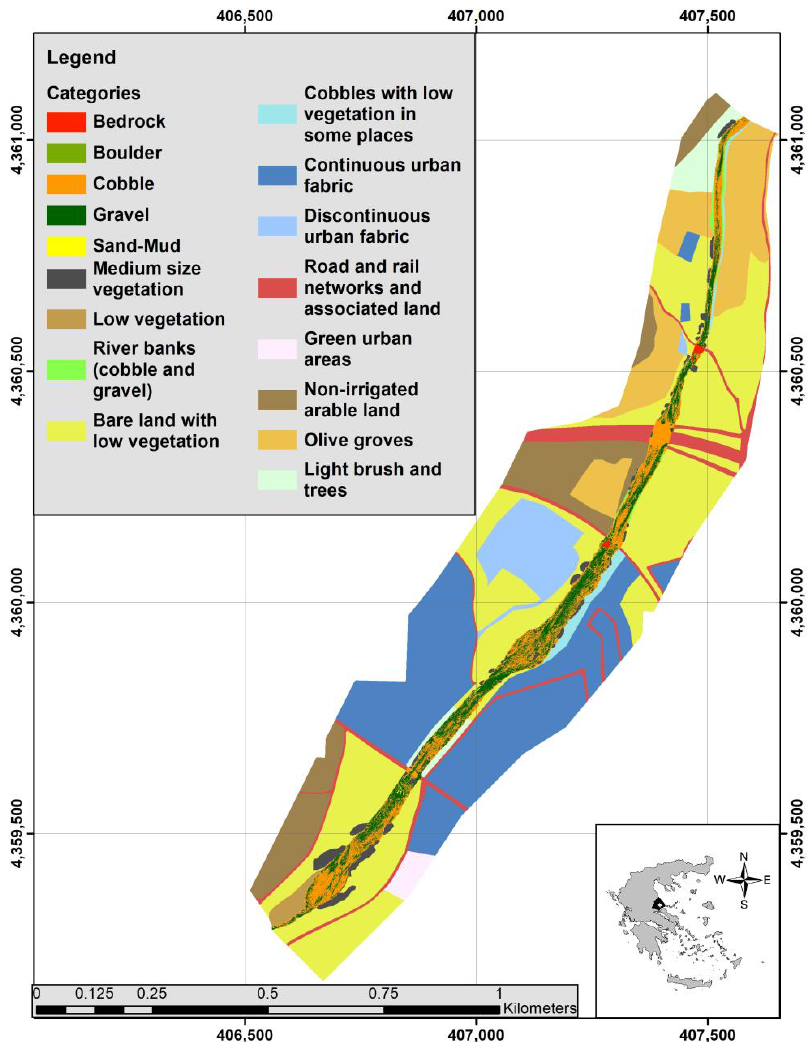
Figure 9. Spatial distribution of Manning’s n roughness coefficient classes.